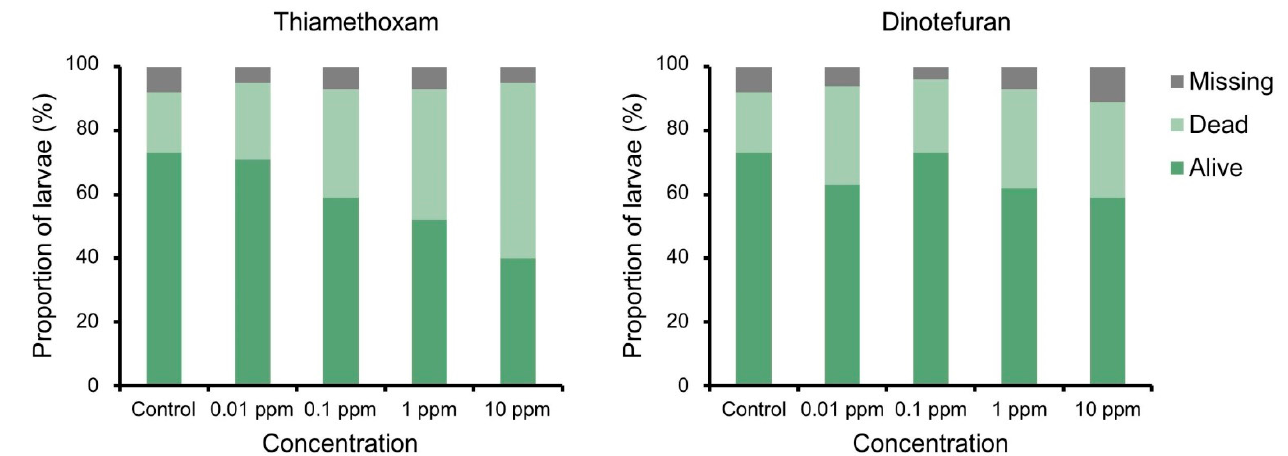
Figure 3. State of Aromia bungii neonates after 3 weeks’ exposure to insecticides.